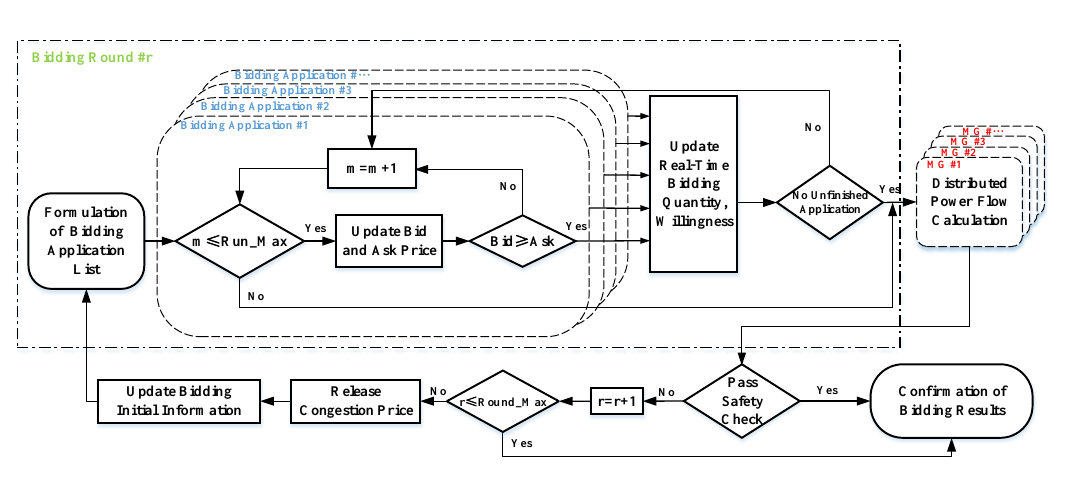
Figure 3. The process of the parallel multidimensional willingness bidding strategy in a time